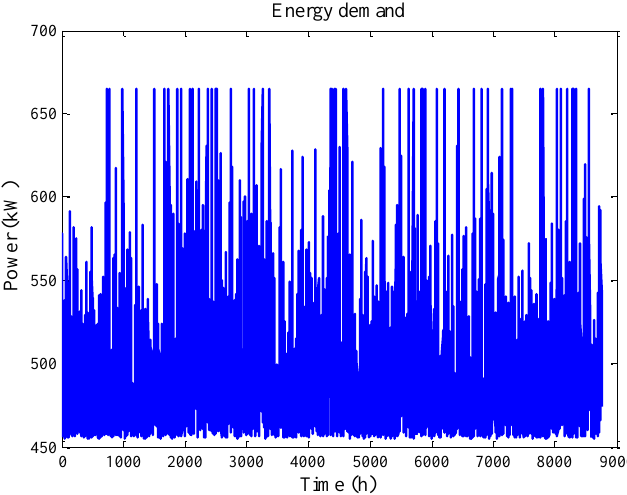
Figure 19. Power demand time series (Case study 2).